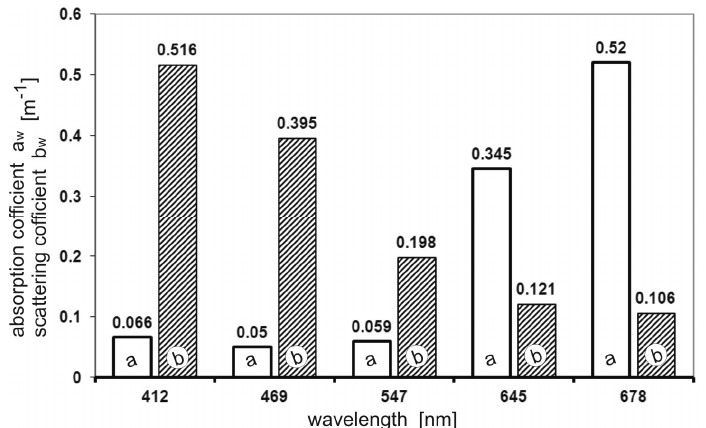
Figure 3. Two components of inherent optical properties (IOPs) of the seawater applied in the model: absorption coefficient a w and scattering coefficient b w . The third component of IOPs—Volume Scattering Function—is used after Petzold [16].